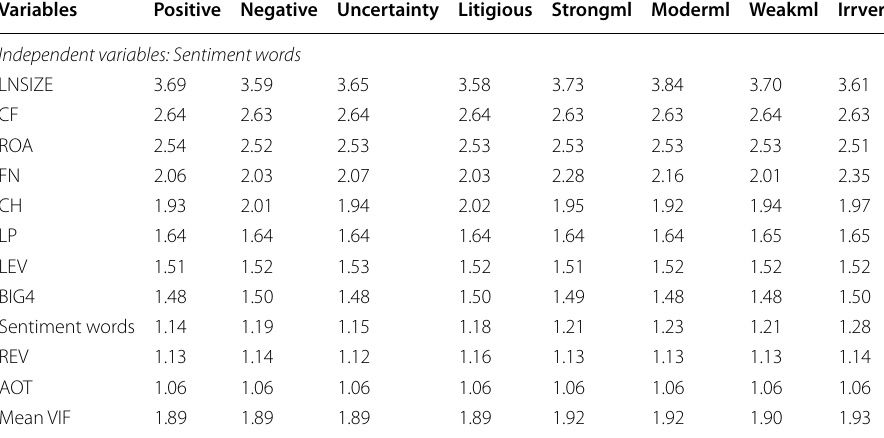
Table 4 Multicollinearity